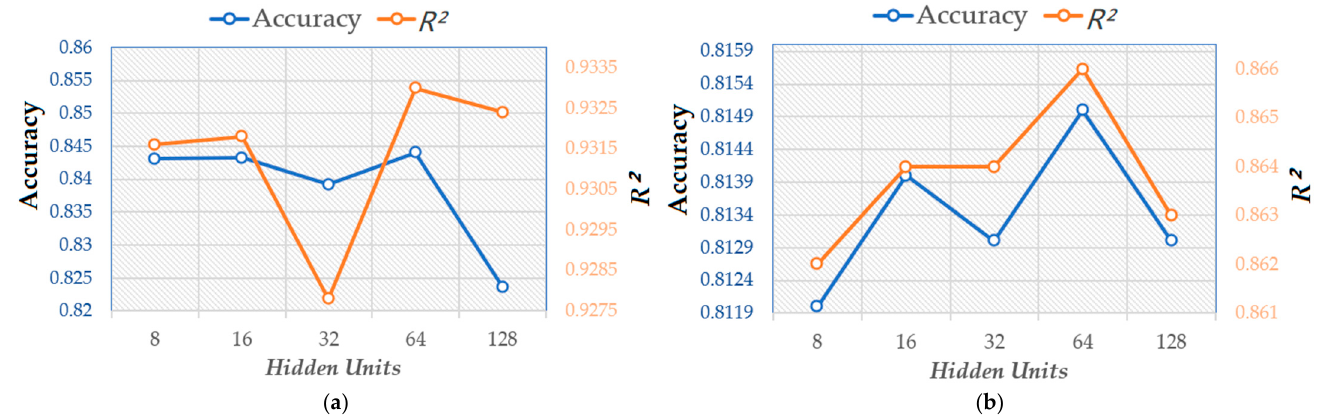
Figure 9. Performance comparison for different numbers of the hidden layers. ( a ) Changes in accuracy and R 2 , based on working days. ( b ) Changes in accuracy and R 2 based on holidays. Table 1. Prediction results for different length sliding